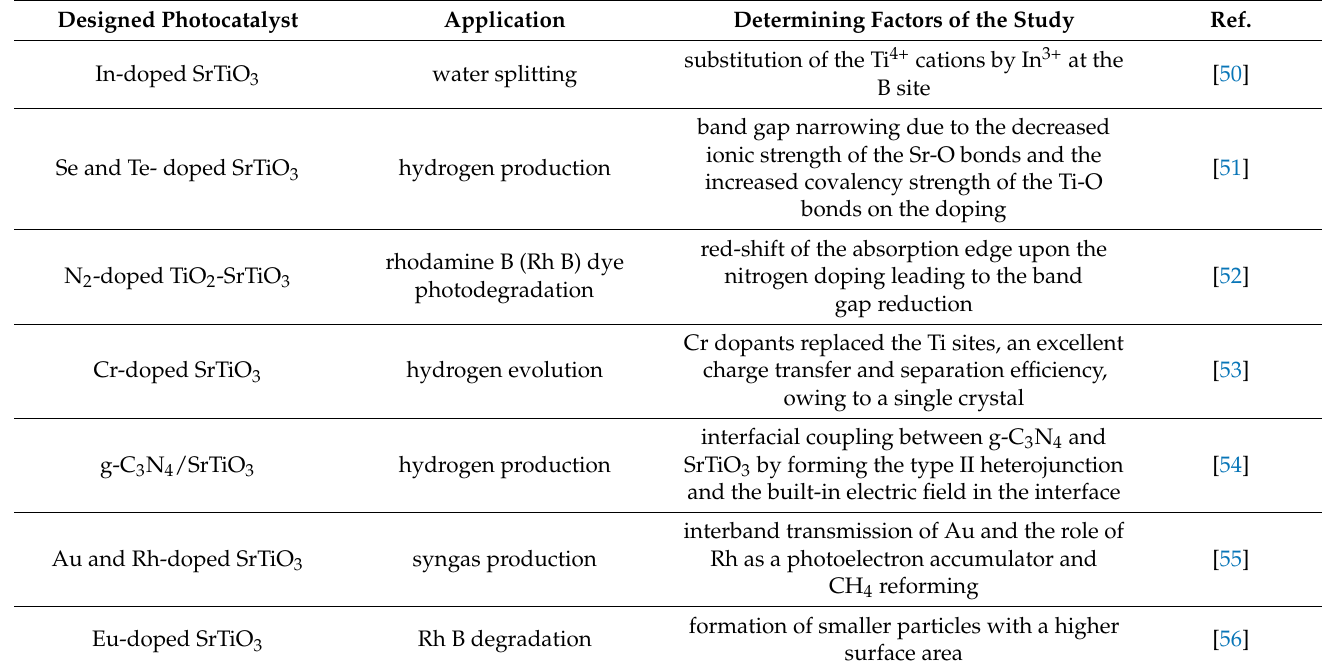
Table 2. Studies on the doping of strontium titanate with different metals and transition metals. Designed Photocatalyst